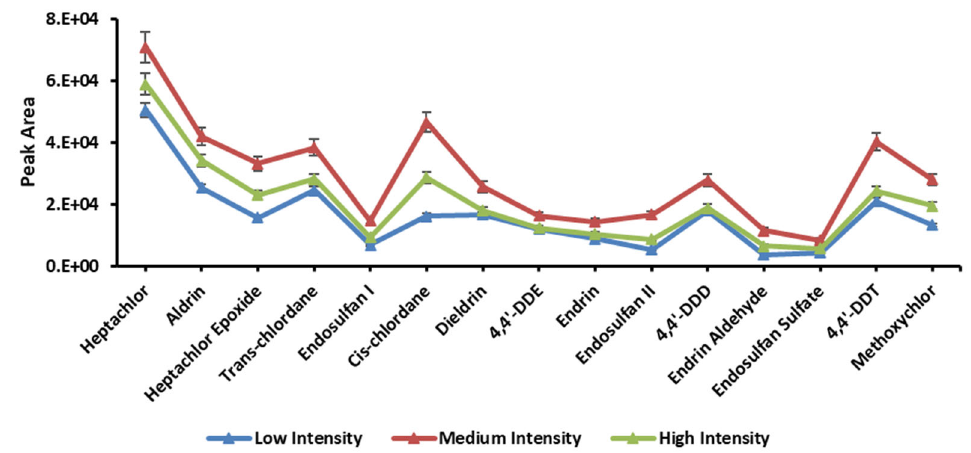
Figure 5. Optimization of ultrasound intensity.